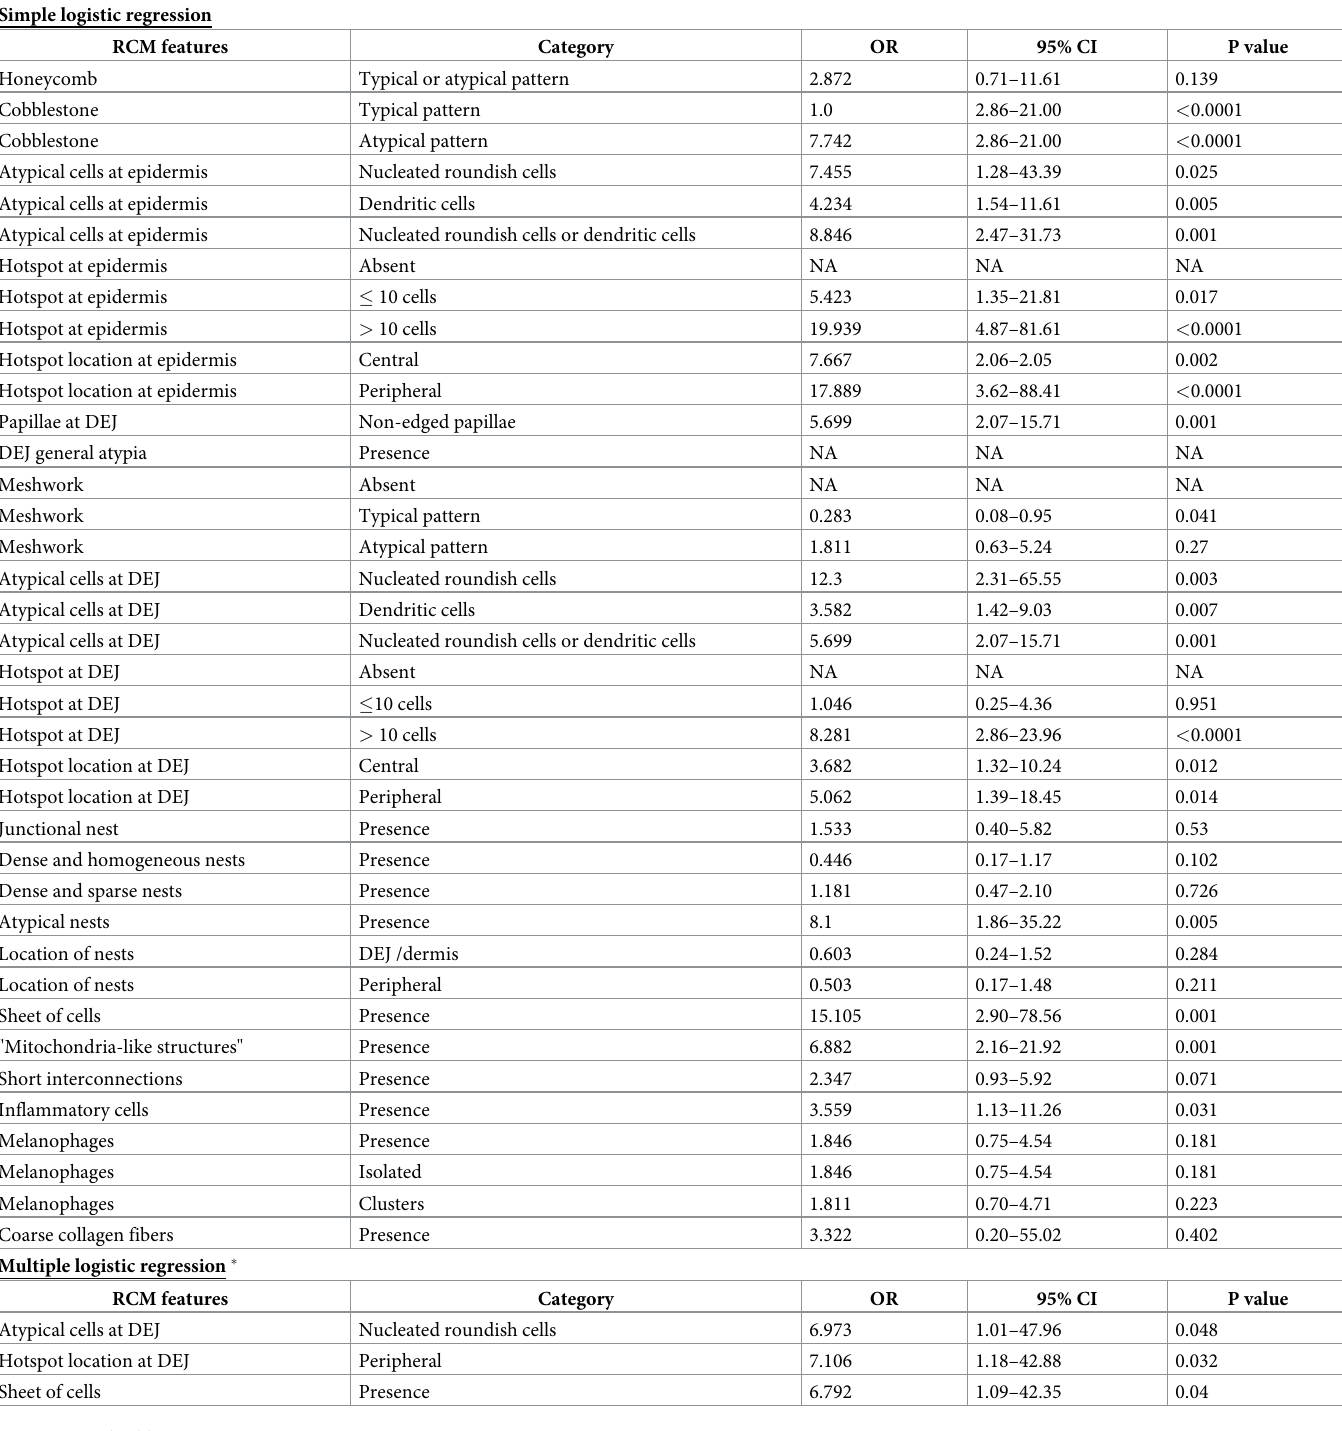
Table 3. Simple and multiple logistic regressions comparing RCM criteria in common and atypical nevi versus melanomas. Simple logistic